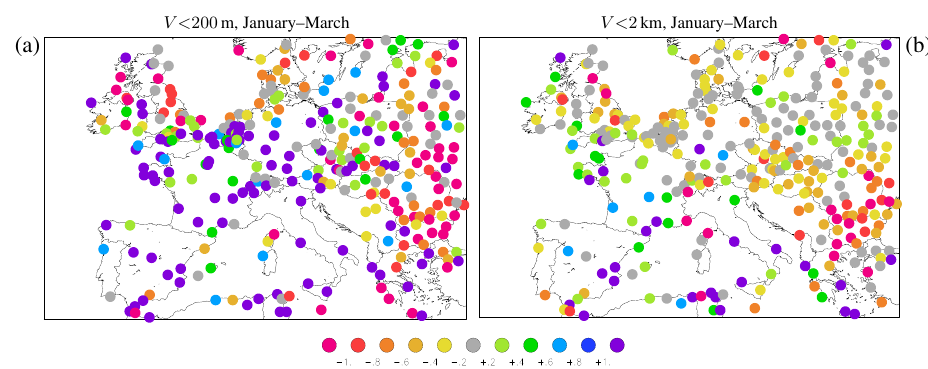
Fig. 17. Relative trend in visibility [%/yr] due to circulation changes in January–March. (a) dense fog (200m), (b) mist (2km).